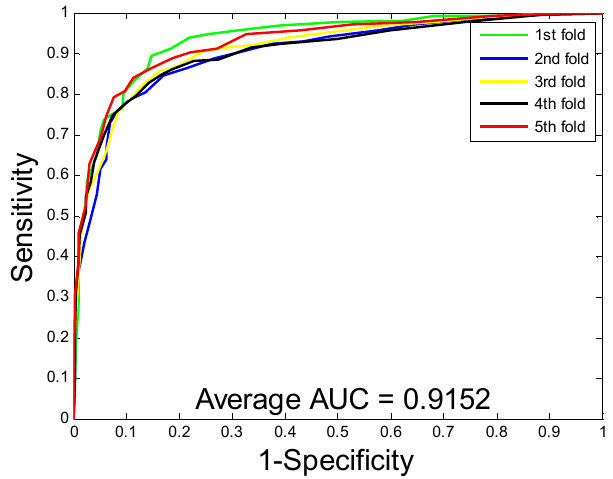
Molecules 2019 , 23 , x Figure 2. The ROC curves are generated by our method on ion channel dataset. Figure 2. The ROC curves are generated by our method on ion channel dataset. Figure 2. The ROC curves are generated by our method on ion channel dataset.